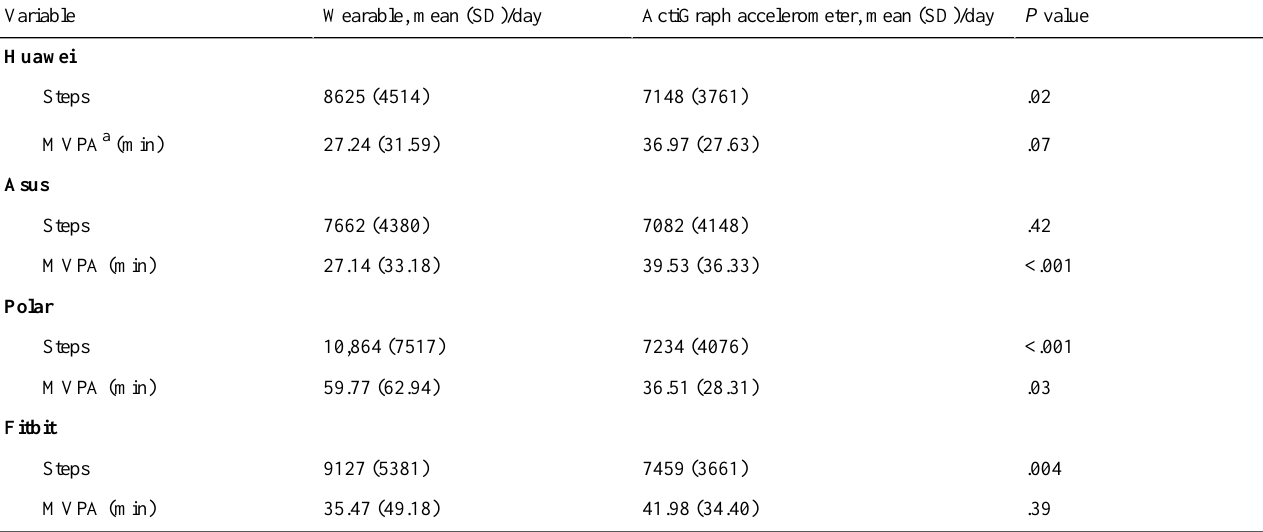
Table 2. Mean steps and minutes of moderate to vigorous physical activity per day measured by Huawei, Asus, Polar, and Fitbit and the